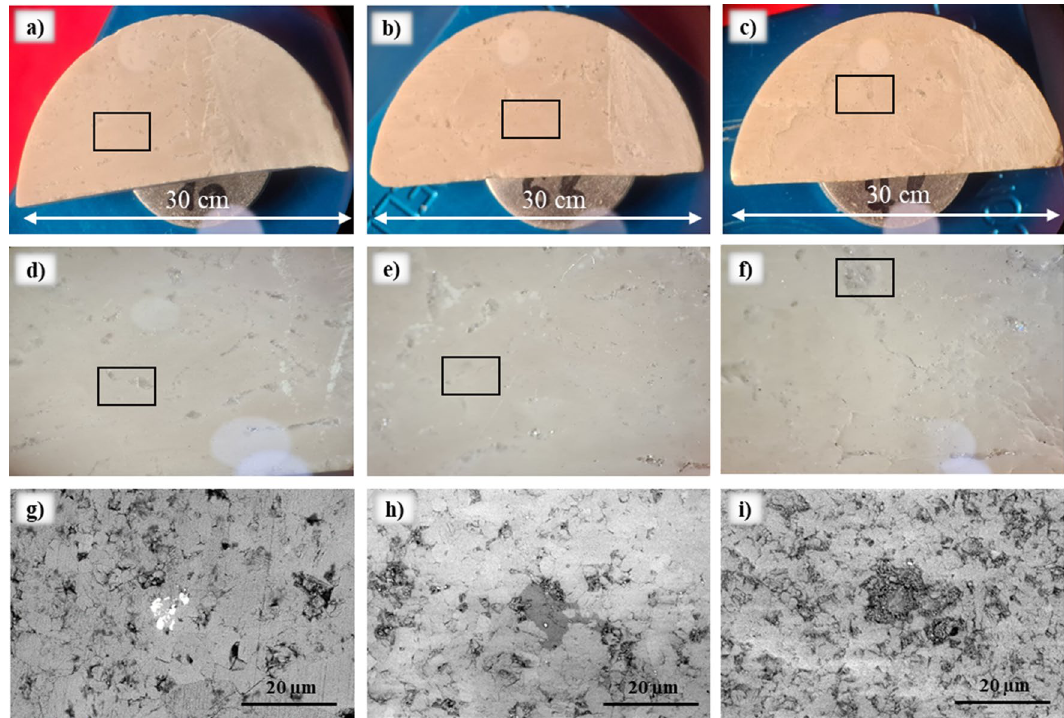
Figure 8. Images of the samples: ( a ) immersed into naphthenic acid solution; ( b ) immersed into palmitic acid solution; ( c ) immersed into stearic acid solution; ( d – f ) zoom into sample areas marked in ( a – c ); ( g – i ) SEM images of the samples areas marked in ( d – f